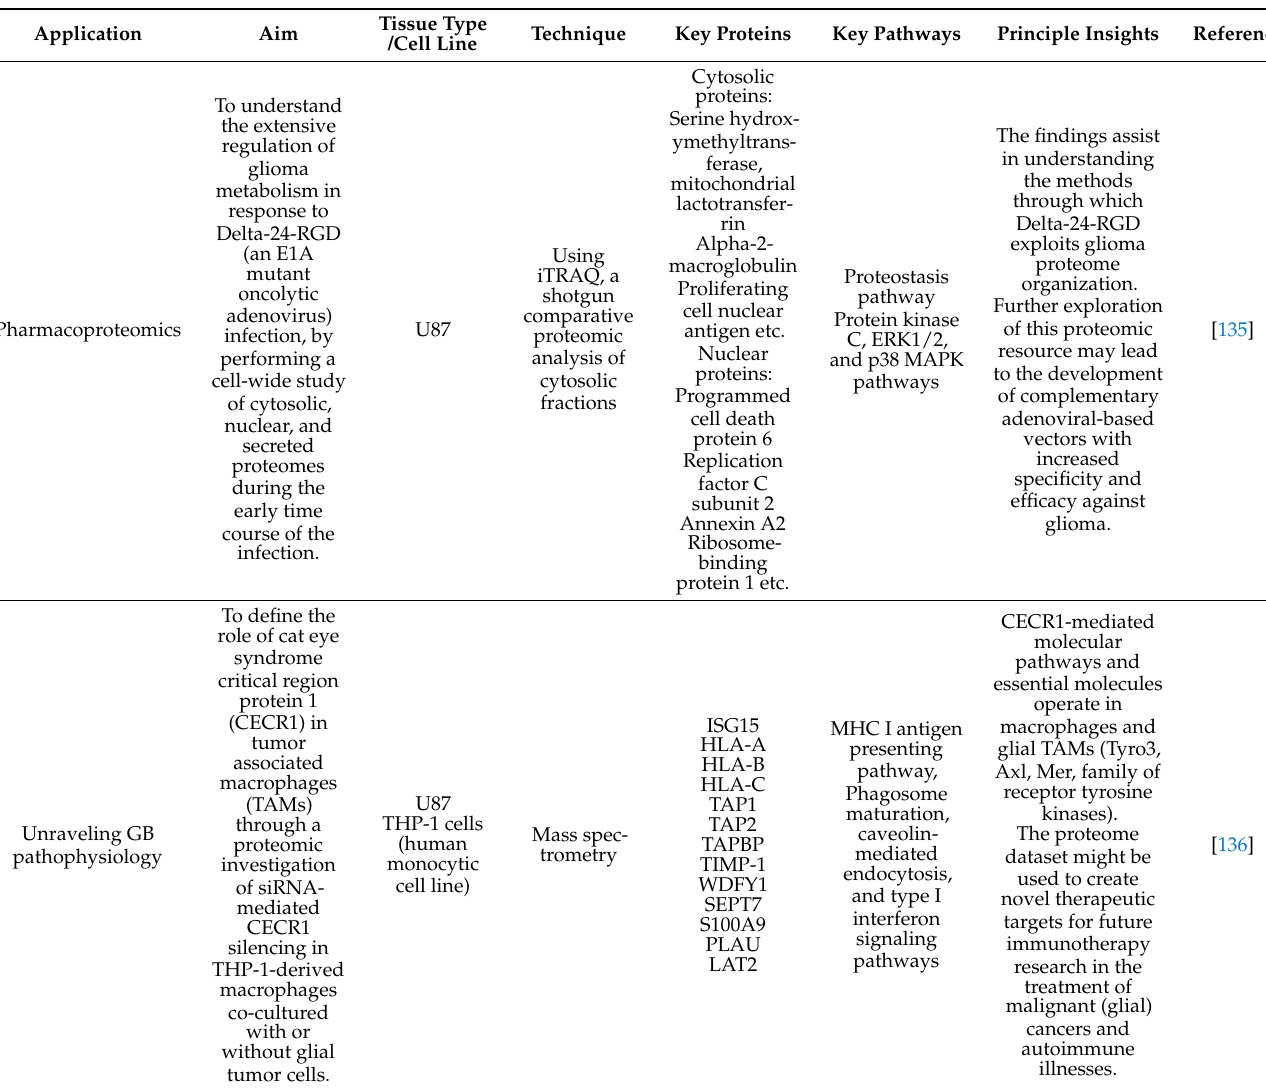
Table 3. Summary of studies employing proteomics in GB